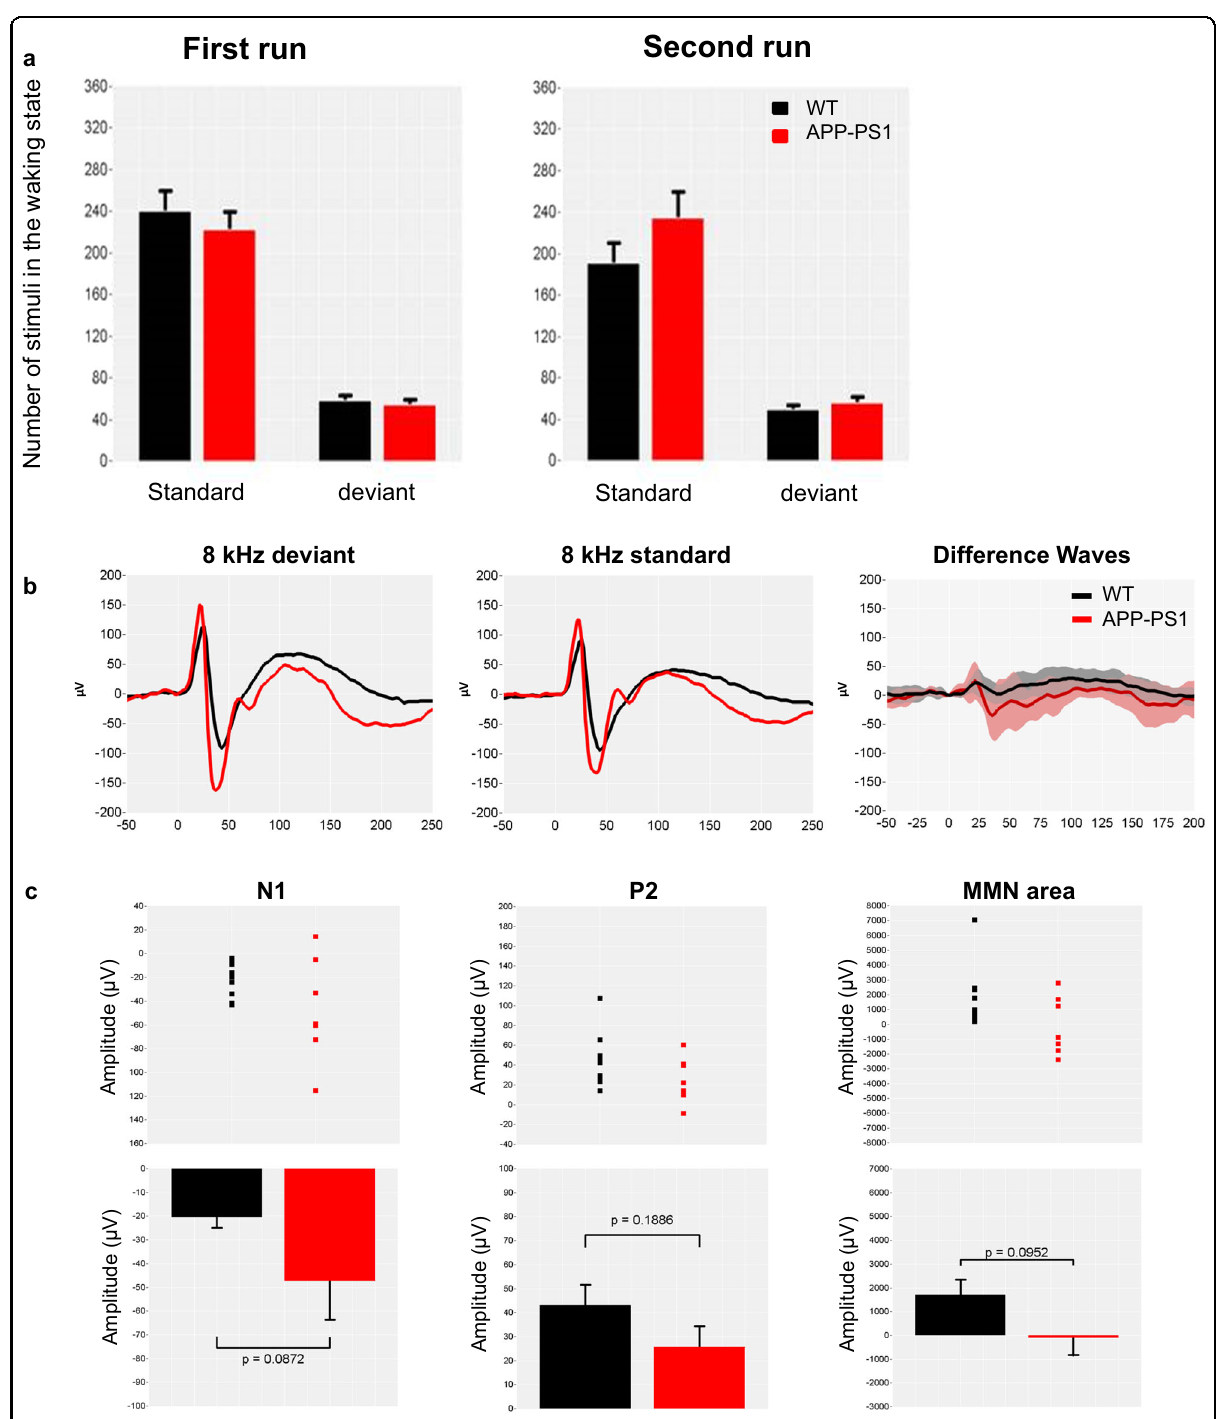
Fig. 4 MMN response in APP/PS1 mice. Grand average-evoked potentials elicited during auditory passive oddball stimulation fl ip- fl op protocol in 13-month-old APP/PS1 and wild-type (WT) mice. a Number of trials categorized as wakefulness for both runs are shown, whereas the remaining AEP responses were discarded from the fi nal analysis. b Changes on standards and deviants ’ stimuli (standard tones of 8 kHz presented at 80% probability; deviant tones of 8 kHz presented at 20% probability) in both genotypes; top-left and middle plots, on difference N1 and P2 waveforms at 20 – 60 ms and 100 – 150 ms after stimulus presentation, respectively; top right, on the MMN area at 50 – 125 ms post stimuli presentation. Average-evoked auditory responses had similar waveforms during the waking state. c Scatterplots of the individual N1 and P1 responses and for the AUC of the N1 differential responses (middle plots). Bar charts showing the mean amplitude values for N1 and P1 responses and for the AUC of the N1 differential responses (bottom plots). Data from three APP/PS1 mice were excluded from the group analysis: in one animal, one electrode was defected and produced artifacts, whereas AEP components were not detectable in two animals. Mean amplitude data are presented as mean +